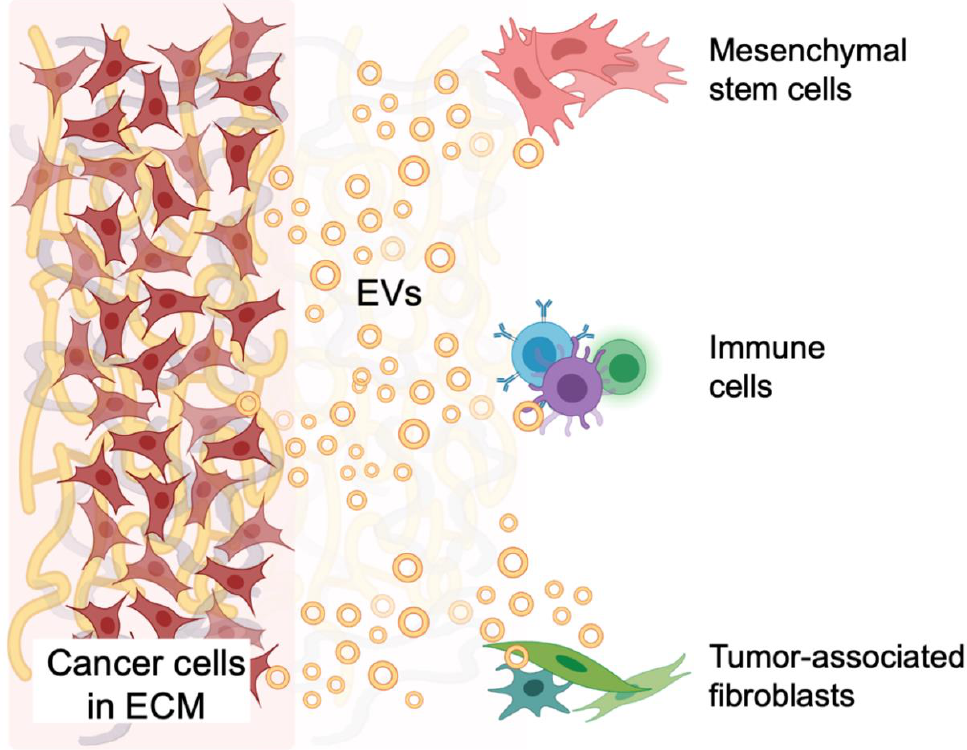
Figure 3. Schematic illustration of how 3D extracellular matrix (ECM) within the tumor microenvironment (TME) can vironment (TME) can affect the phenotype of tumor cells and biogenesis of extracellular vesicles affect the phenotype of tumor cells and biogenesis of extracellular vesicles (EVs) and how EVs interact with ECM and (EVs) and how EVs interact with ECM and subsequently signal to tumor-associated stromal cells subsequently signal to tumor-associated stromal cells such as mesenchymal stem cells, immune cells and tumor-associated such as mesenchymal stem cells, immune cells and tumor-associated fibroblasts. Created with fibroblasts. Created with BioRender.com (accessed on 3 April 2021). BioRender.com (accessed on 3 April